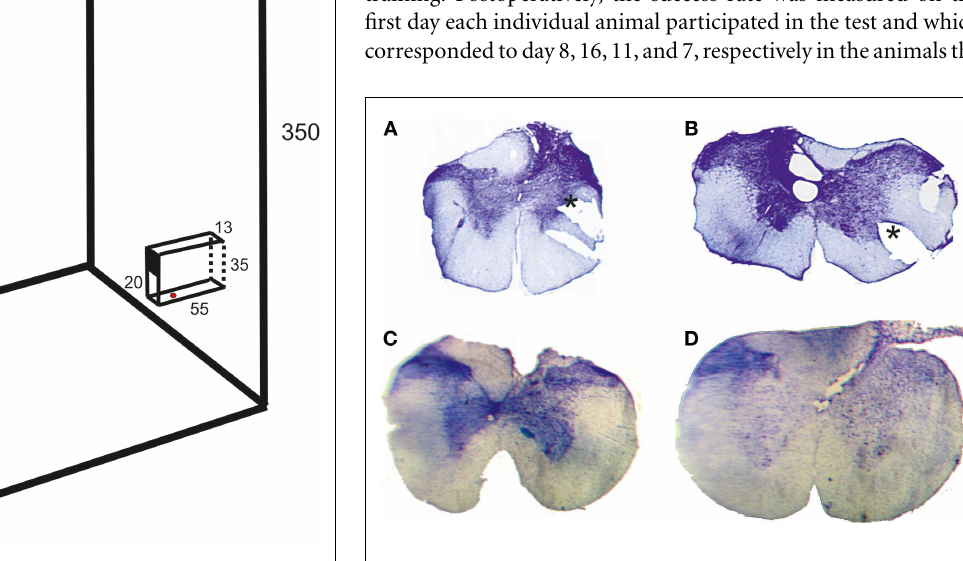
FIGURE 2 | Histological control .Transverse extent of spinal selective lesions in four rats (A–D) giving complete interruption of the CST but with remaining fibers in unlesioned areas of the DC.The asterisks in (A,B) show the position of a notch cut, after fixation, in the lateral funicle on one side to identify that side of each section when mounting